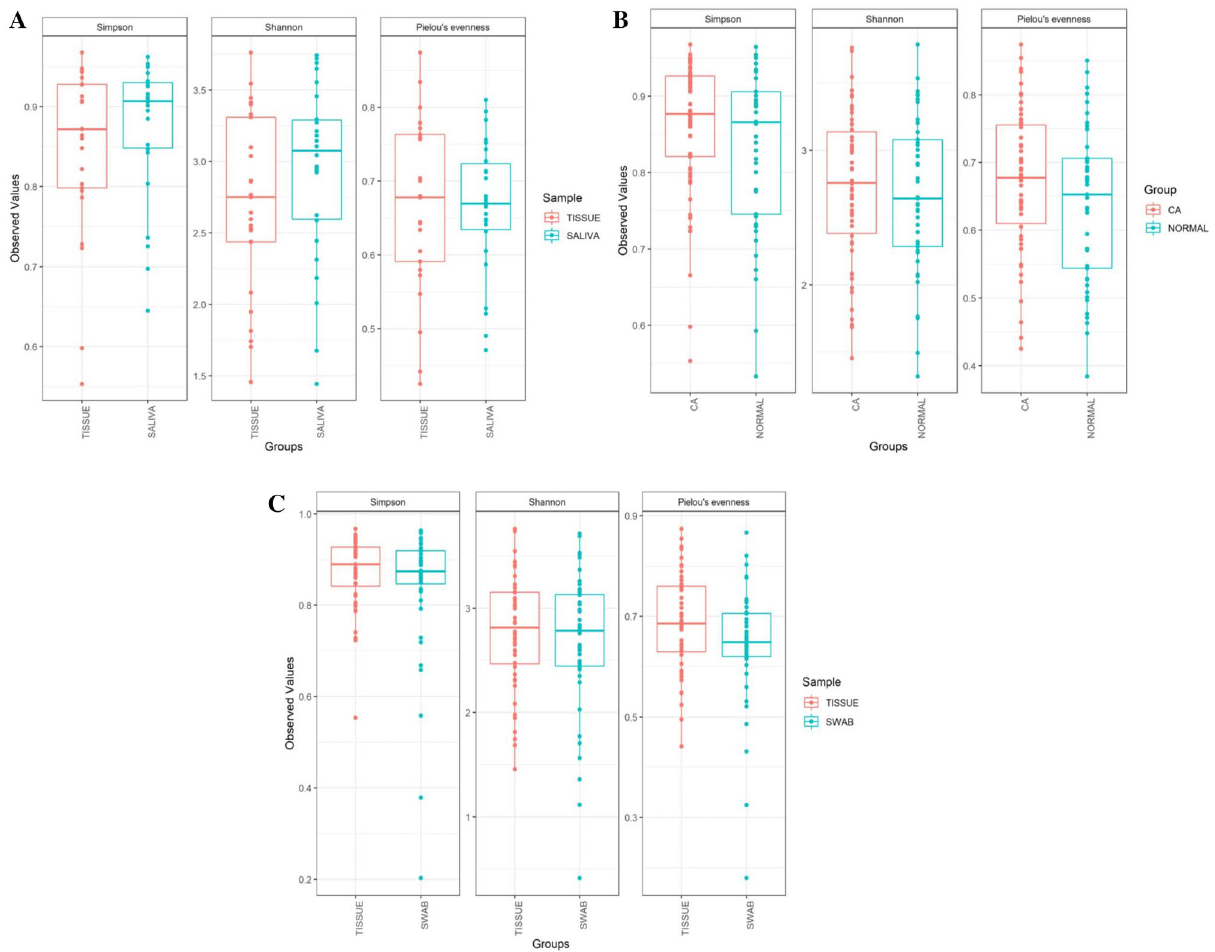
Figure 9. Box plot illustrating alpha diversity indices. No statistically significant difference in diversity was observed between the groups compared (P > 0.01) ( A) CA vs controls, ( B) tissue vs swab, ( C) tissue vs